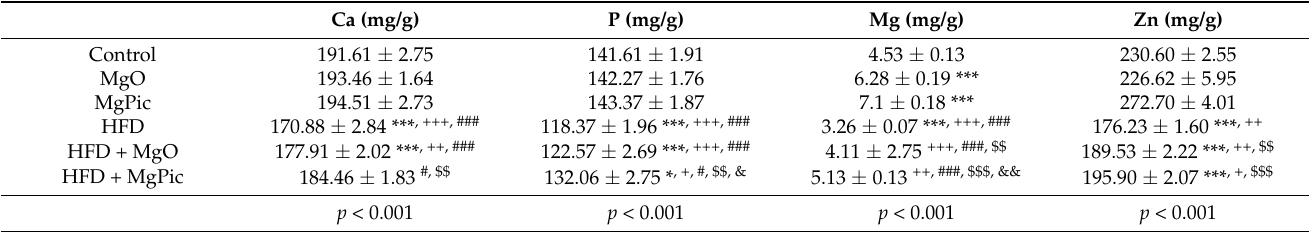
Table 4. Effects of MgO or MgPic supplementation on bone Ca, P, Mg, and Zn levels in